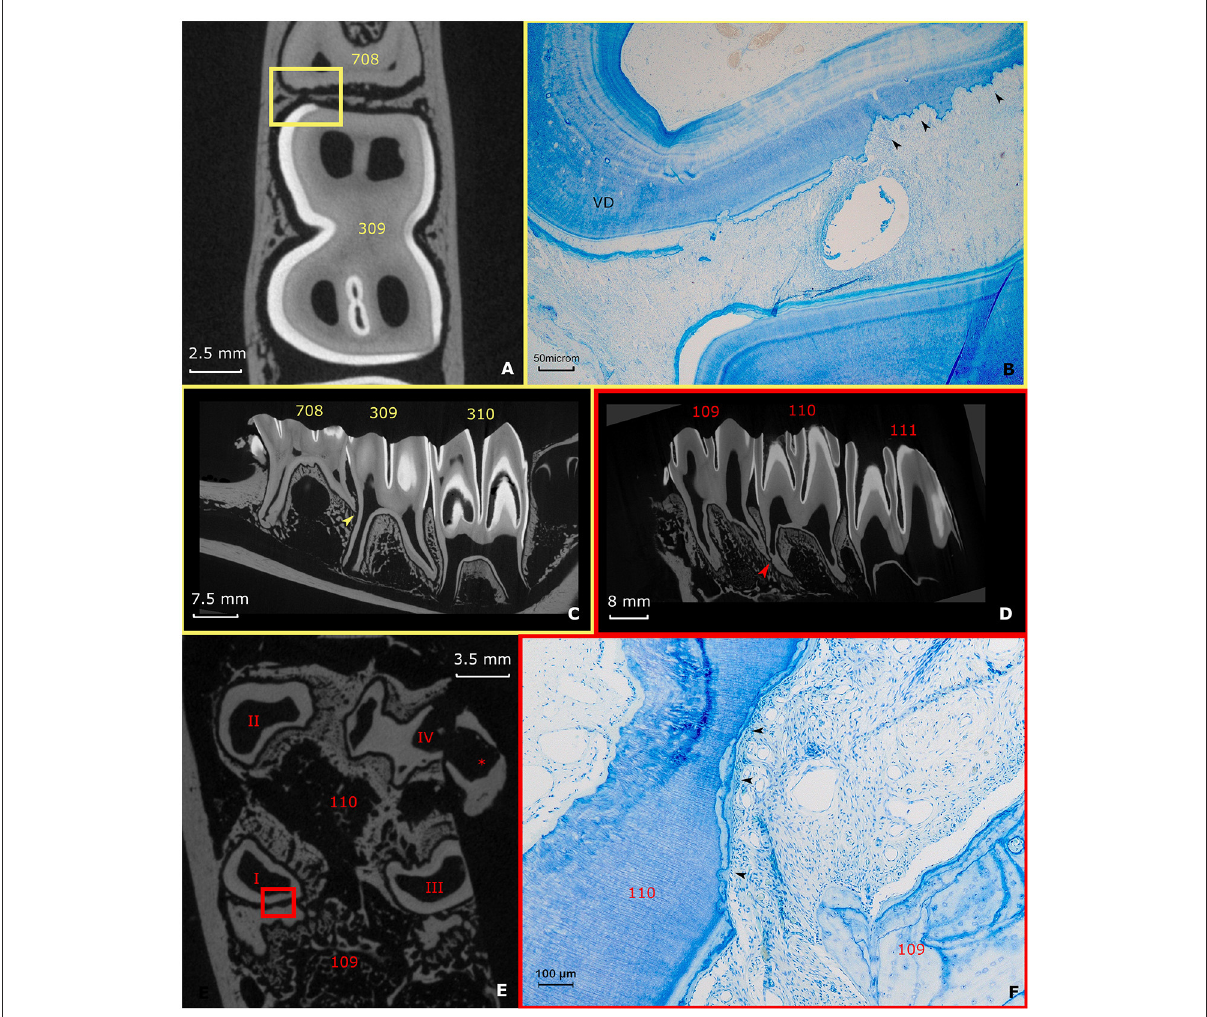
FIGURE7 Root contacts and lytic zones (A–C) (yellow). A Root contact between the roots of a deciduous fourth premolar and permanent first molar in the left lower jaw in a 3-years-old animal. The apical end of root II of the deciduous fourth premolar (708) is in contact with the mid-tooth region of the first molar in the left lower jaw (309). (A) Transverse section 10mm subocclusaly. Note the close proximity of the adjacent dental structures in this specific figure. Also, the lining of the dental tissue of the deciduous fourth premolar in the left lower jaw (708) appears irregular. A small yellow box indicates the range of the accompanying histological figure. (B) Histological decalcified section (10mm subocclusal) of the region of contact indicated by a yellow box in (A) . Black arrows show the lytic front advancing in the dentin in the caudal region of root II of the deciduous fourth premolar in the left lower jaw. Note the presence of vasodentin (VD) at the root level of the deciduous fourth premolar in the left lower jaw (Toluidin Blue, 5x magnification). (C) Sagittal µ -CT image illustrating the root contact between the deciduous fourth premolar and first molar in the left lower jaw (yellow arrow) (D–F) (Red). Root contact between the roots of a first and second molar in the right upper jaw in a 4 years and 3 months alpaca. (D) Two-dimensional sagittal µ -CT section illustrating the root contact between the roots of a first and second molar in the right upper jaw (red arrow). (E) Transverse 17mm subocclusal two-dimensional µ -CT image illustrating the region of contact between the roots of the first and second molar in the right upper jaw. Note the irregular border of the contacting root structures (red box). * illustrates an artifact originating from the extraction of the dental arche from the skull. (F) Histological section at the apical region (17mm subocclusal) of root I. Large amount of low cellular cementum present at a first molar in the right upper jaw (109). The mesial front of root I of a second molar in the right upper jaw (110) shows a lytic front proceeding into the dentin (black arrows). A small quantity of low cellular cementum is visible peripherally from the lytic front. (Toluidin, 10x